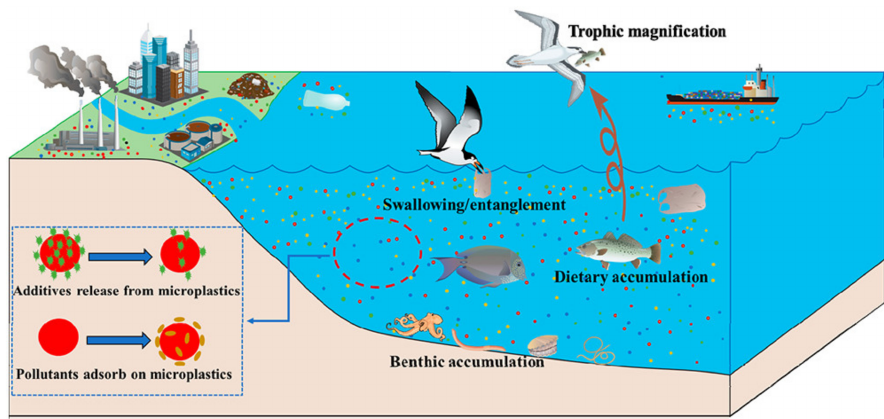
Figure 3. Photodegradation of microplastics and their activities in water environments